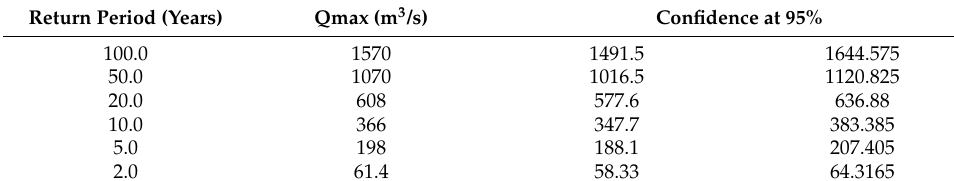
Table 3. Estimation of the return period by the normal Log law at the Laayoune station.